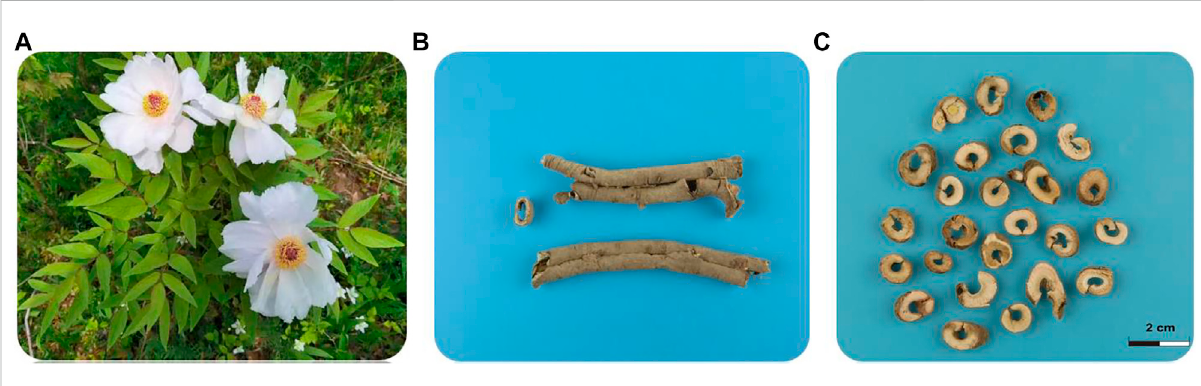
FIGURE 1 Whole plant, root bark and medicinal slices of Paeonia suffruticosa. (A) P. suffruticosa fl owers in early May each year and lasts about a week. (B) Cortex Moutan, the root bark of P. suffruticosa , is rich in a variety of medicinal value substances, which can be used for the treatment of a variety of diseases. (C) Medicinal slices of Cortex